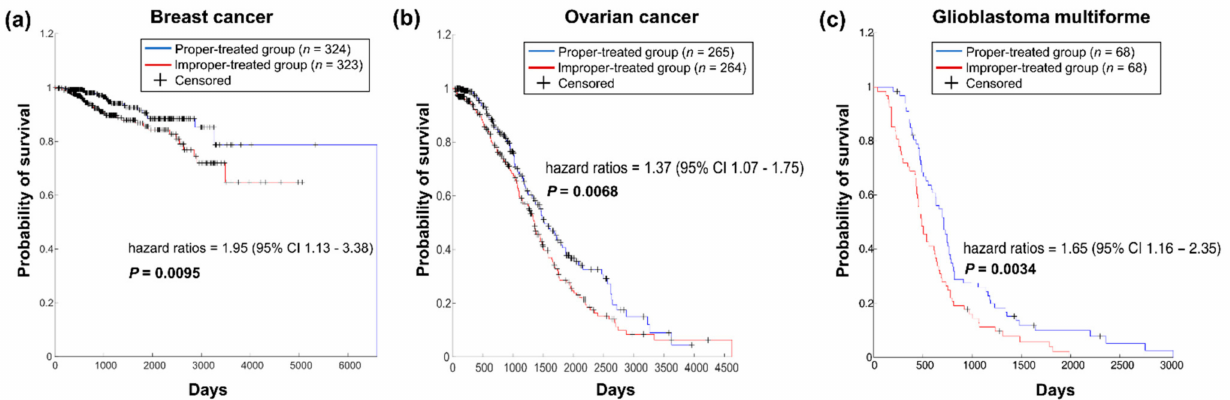
Figure 3. Survival analysis of the two patient groups divided by administration of the appropriate therapy. ( a ). Survival analysis of BC patients. ( b ). Survival analysis of OV patients. ( c ). Survival analysis of GBM cancer